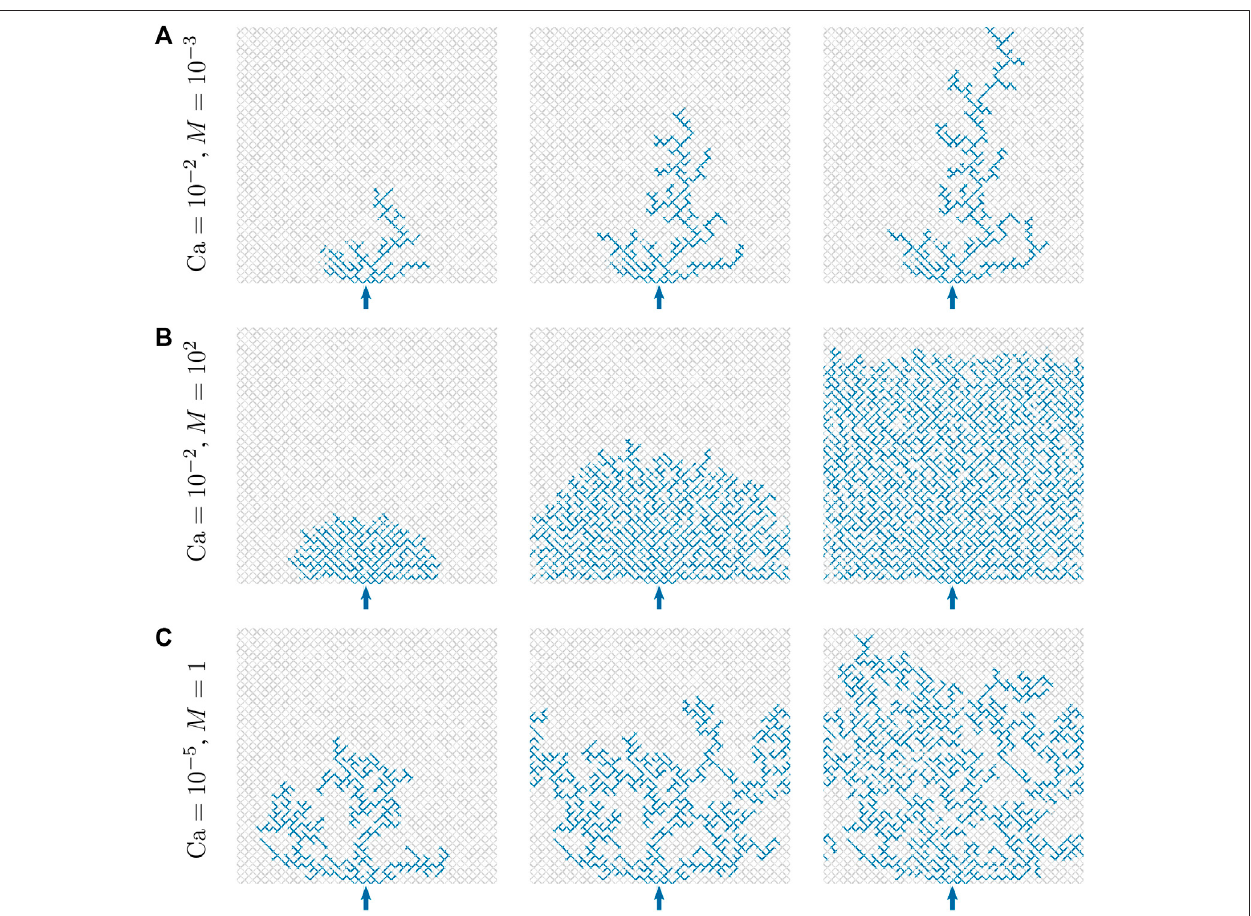
FIGURE9| Developmentoftransient fl owpatternsduringthedrainagesimulationsinadisorderedsquarenetworkof64 × 64links.Thenetworkisinitially fi lledwith wetting fl uid (gray) and the non-wetting fl uid (blue) is injected through four inlet nodes at the bottom edge of the network, shown by the arrow, with a constant fl ow rate. Thetopedgeofthenetworkiskeptopenwhichworksastheoutlet.Periodicboundaryconditionsareappliedinthehorizontaldirection,thereforetheleftandrightedges areconnectedtogether.OnlythecapillarynumberCaandtheviscosityratioMarealteredduringthesesimulationsandallother fl owparametersandthealgorithms for meniscus dynamics are exactly the same. The fl ow patterns show the different regimes of transient two-phase fl ow, namely (A) the viscous fi ngering (B) the stable displacement and (C) the capillary fi ngering. We like to point out that, though we adopted “ democratic ” rules for meniscus algorithms, it is the solution of the fl ow equations that lead the fl uids to generate these different fl ow patterns.